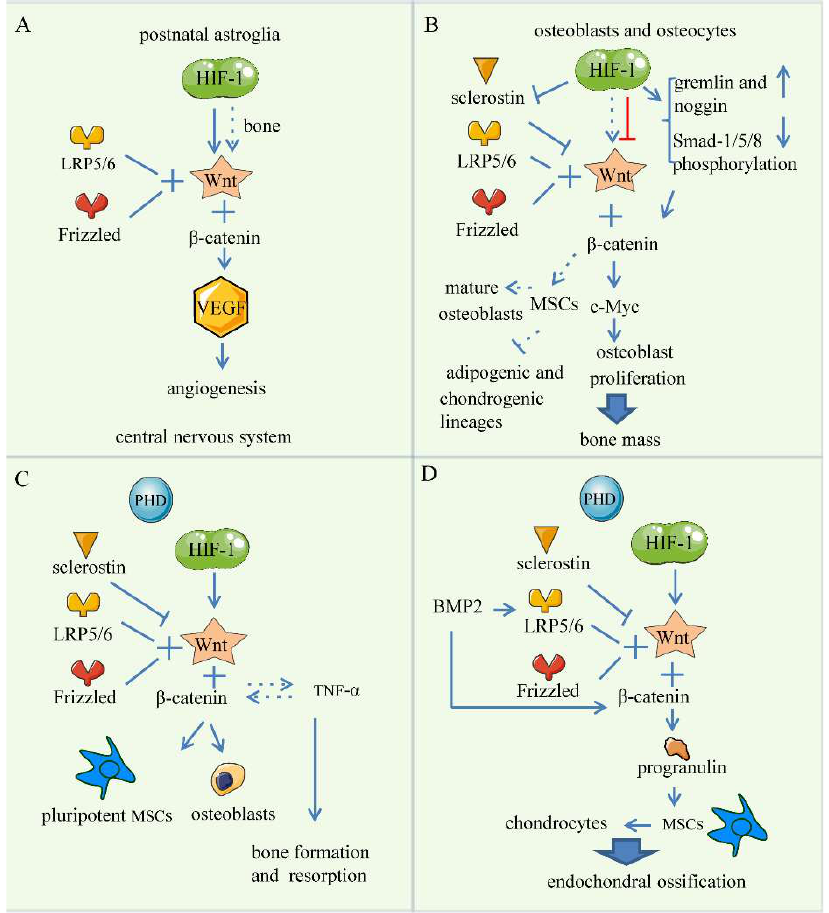
Figure 5. Wnt Signaling Pathway. ( A ) Bone angiogenesis. HIF-1 up-regulates Wnt7a/7b in oligoden- drocyte precursor cells, and Wnt/β-catenin signaling regulates VEGF transcription and promotes vessel growth. ( B ) Endochondral bone formation. HIF-1 activates Wnt to increase the expression levels of c-Myc to promote the osteoblast proliferation. Sclerostin inhibits Wnt signaling. HIF-1 increases expression of the BMP antagonists and decreases Smad-1/5/8 phosphorylation to decrease sclerostin transcript in osteoblasts and osteocytes. β-catenin promotes the differentiation of MSCs into mature osteoblasts and inhibits the differentiation into adipogenic and chondrogenic lineages. HIF-1 is also found to inhibit Wnt signaling. ( C ) Skeletal repair. The interaction between the Wnt pathway and TNFα mediates inflammatory process and regulates the balance between skeletal bone formation and resorption. ( D ) Skeletal repair. Wnt pathways regulate the progranulin that promotes the differentiation of MSCs into chondrocytes as well as endochondral ossification. BMP2 increases the expression of LRP5 and stabilizes β -catenin promoting osteogenic